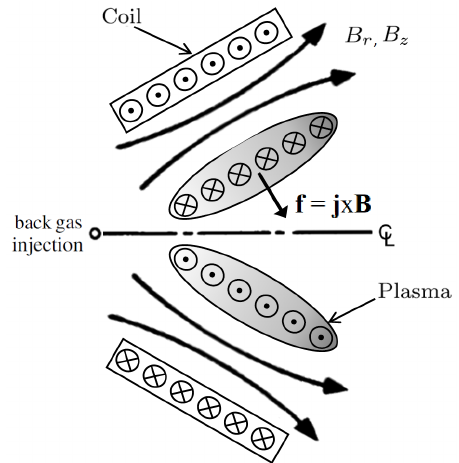
Figure 6. Schematic showing the basic operation of an open magnetic flux conical theta-pinch inductive pulsed plasma thruster. The Lorentz body force f , with components in the radial axial directions, arises from the interaction between the azimuthal plasma current density j = magnetic field components B = B r ˆ r + B z ˆ z